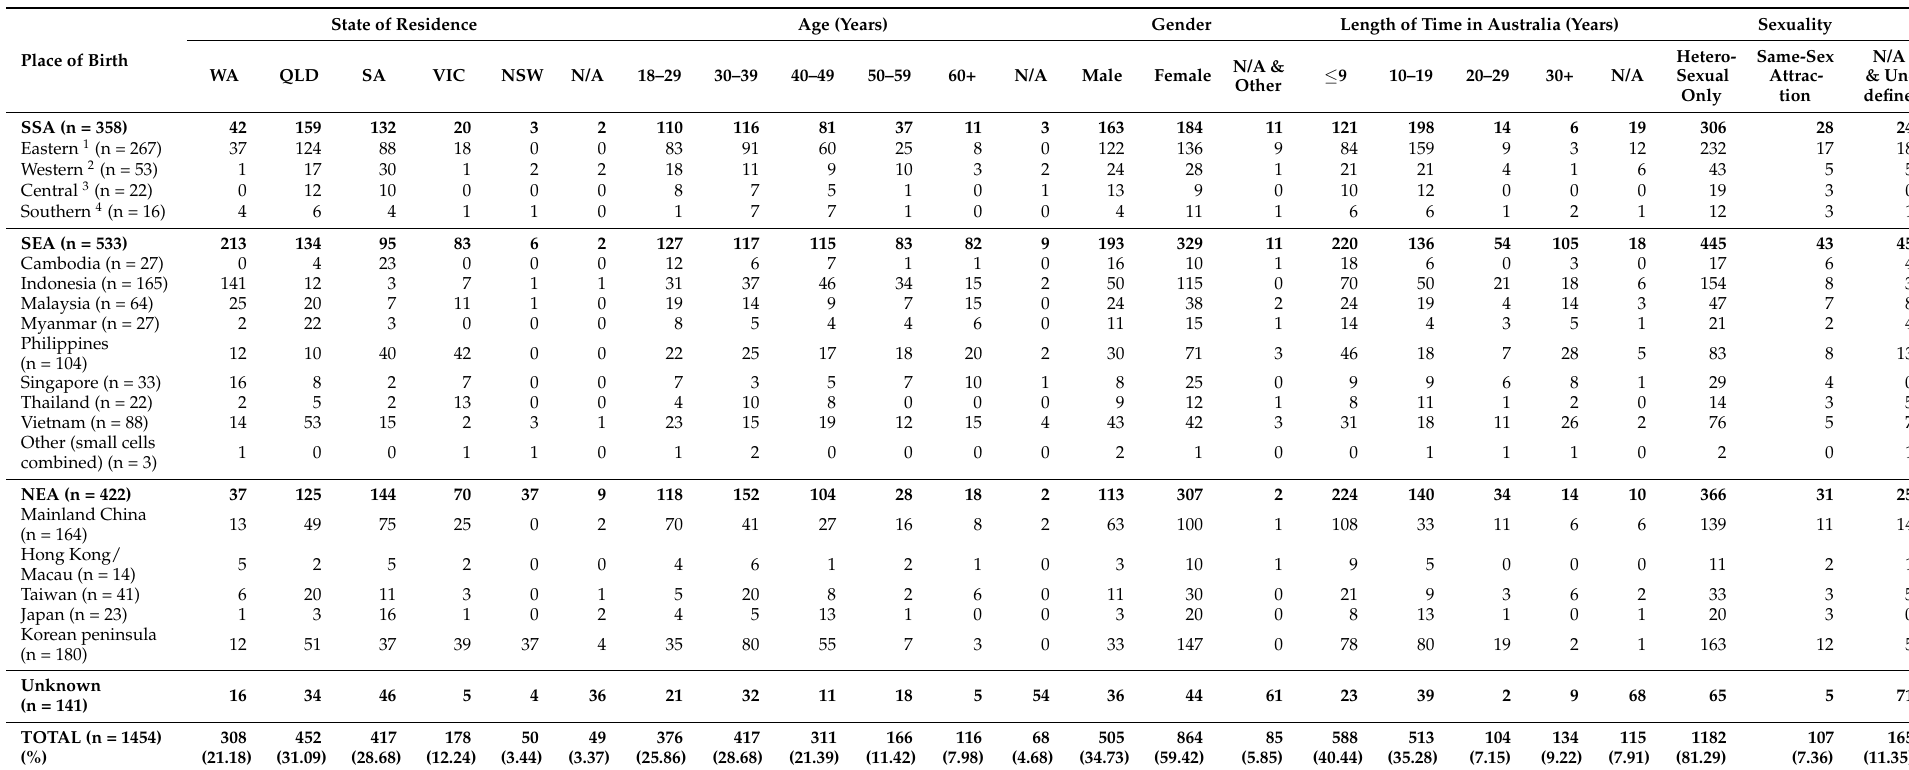
Table 3. Number of respondents according to region of birth, state of residence, age, gender, time in Australia, and